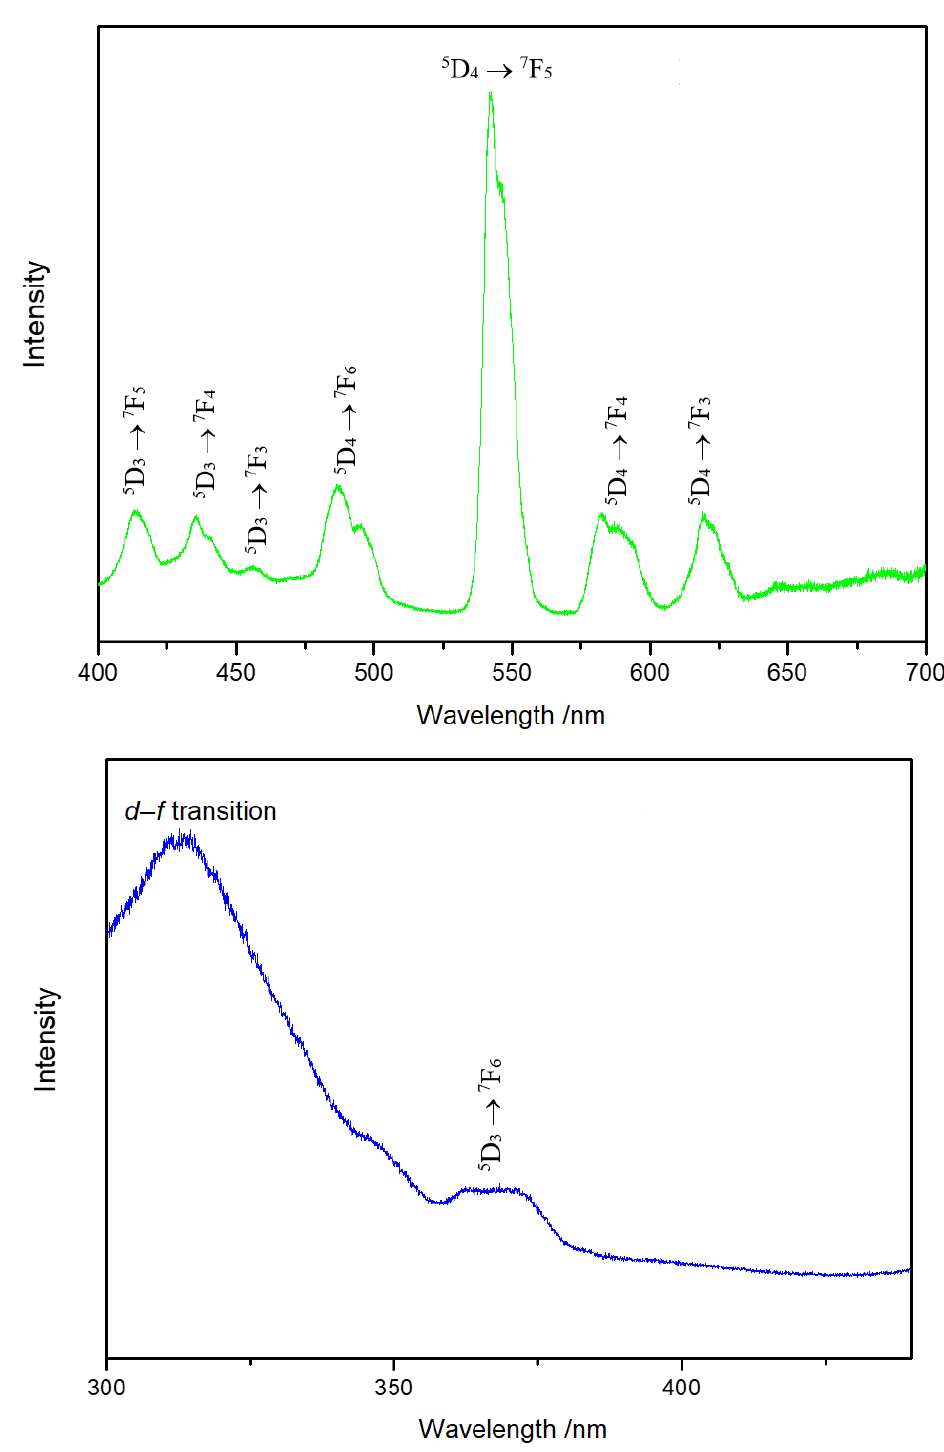
Figure 7. Emission spectrum of Y 3 F[Si 3 O 10 ]:Tb 3+ excited at 370 nm at room temperature ( top ). Excita- tion spectrum of Y 3 F[Si 3 O 10 ]:Tb 3+ detected at the emission energy of 485 nm at room temperature ( bottom